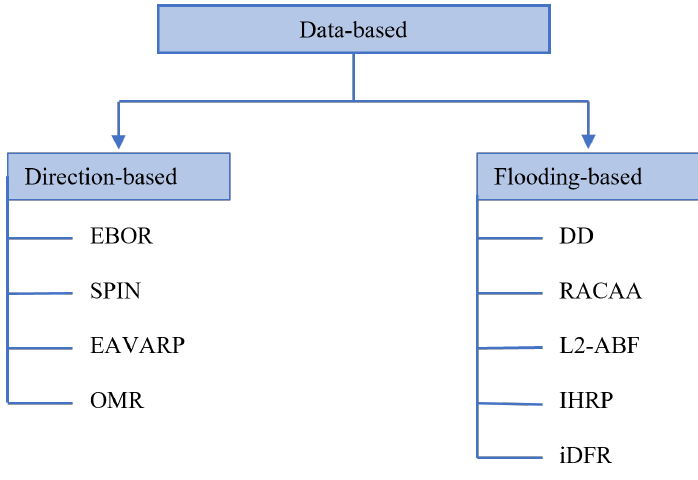
Figure 7. Taxonomy of data-centric routing